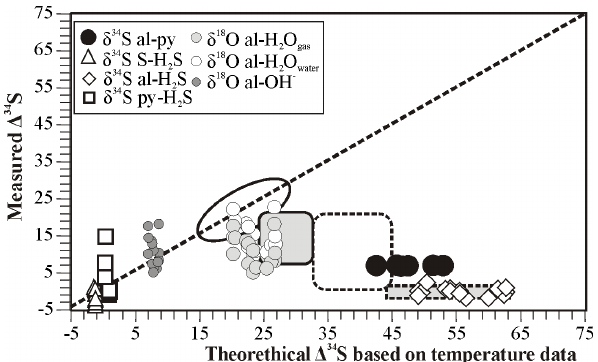
Figure 10. Measured vs. theoretical fractionation values. Theoret- ical values based on temperature measurements were calculated following Ohmoto and Rye (1979) and Rye et al. (1992). Fields for steam-heated (white) and supergene (gray) environments are from Rye et al. (1992): dashed envelop for alunite–pyrite (circle) or alunite–H 2 S (rhombus) pairs, continuous envelop for alunite–H 2 O.